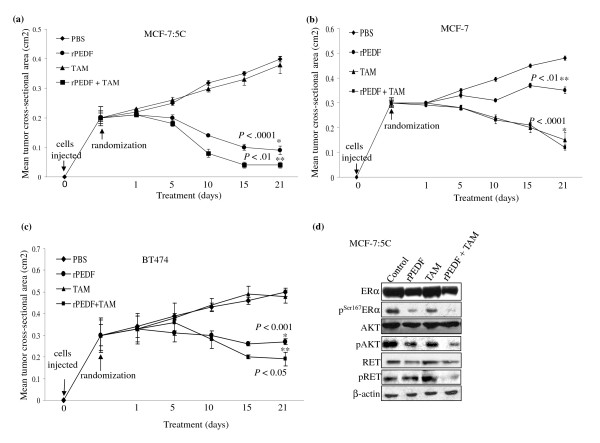
Effect of recombinant pigment epithelium-derived factor on tamoxifen sensitivity in MCF-7:5C, MCF-7, and BT474 xenografts. (a) MCF-7:5C cells were bilaterally injected into the mammary fat pads of ovariectomized athymic mice (n = 32), and after tumors reached a mean cross-sectional area of 0.2 cm2 groups of eight mice were randomly assigned to the following treatments: PBS (control), recombinant pigment epithelium-derived factor (rPEDF), tamoxifen (TAM), or rPEDF + TAM. TAM was given orally by gavage at 1.5 mg/day and rPEDF was given via intraperitoneal injection at 4 mg/kg every other day for 21 days. (b) MCF-7 cells were bilaterally injected into the mammary fat pads of ovariectomized mice (n = 32), and after tumors reached a mean cross-sectional area of 0.32 cm2 groups of eight mice were randomly assigned to the following treatments: PBS (control), rPEDF, TAM, or rPEDF + TAM as described in Materials and methods. (c) BT474 cells were bilaterally injected into the mammary fat pads of ovariectomized mice (n = 32), and after tumors reached a mean cross-sectional area of 0.3 cm2 groups of eight mice were randomly assigned to the following treatments: PBS (control), rPEDF, TAM, or rPEDF + TAM. Mean cross-sectional tumor area was measured every 5 days with vernier calipers. Cross-sectional areas were calculated by multiplying the length (l) by the width (w) and by π and dividing the product by 4 (that is, lwπ/4). (d) Western blot analysis of MCF-7:5C tumors following treatment with rPEDF, tamoxifen, or rPEDF and tamoxifen. Tumors were generated as described in 7a and the lysates were preprepared as described in Materials and Methods. Blots were probed with the indicated antibodies.